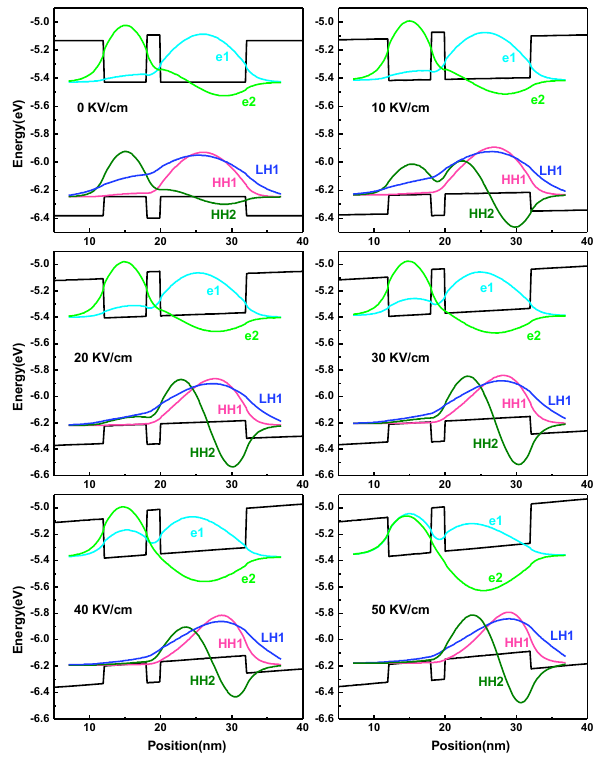
Figure 6: Simulated wave functions at the Γ point of the Ge/SiGe CQWs under the electric field of: 0, 10, 20, 30, 40 and 50